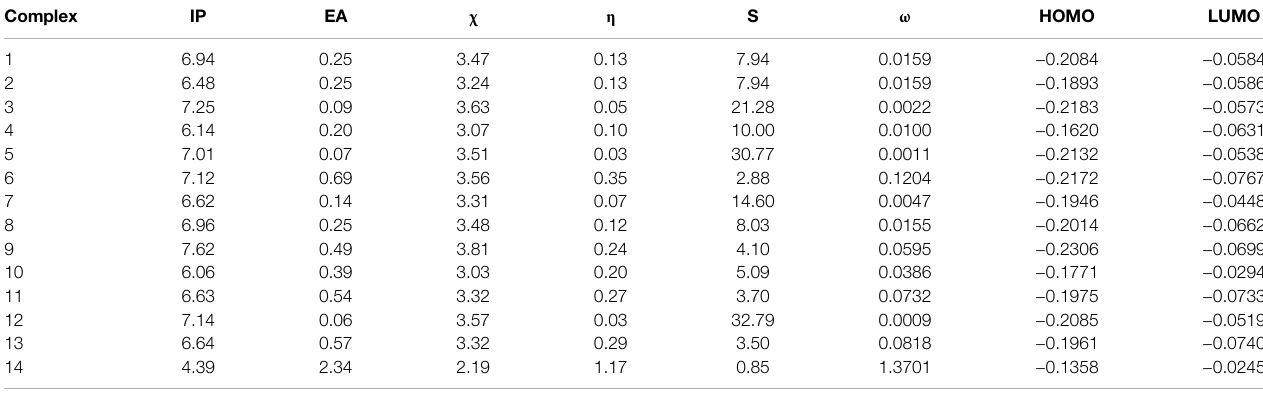
TABLE 2 | Calculated [ionization energy (lP), electron af fi nity (EA), and global reactivity descriptors; electronegativity ( χ ), global hardness ( η ), global softness (S), and global electrophilicity index ( ω )] in eV and highest occupied molecular orbital (HOMO) and lowest unoccupied molecular orbital (LUMO) (au) for 14 multikinase inhibitors. Complex